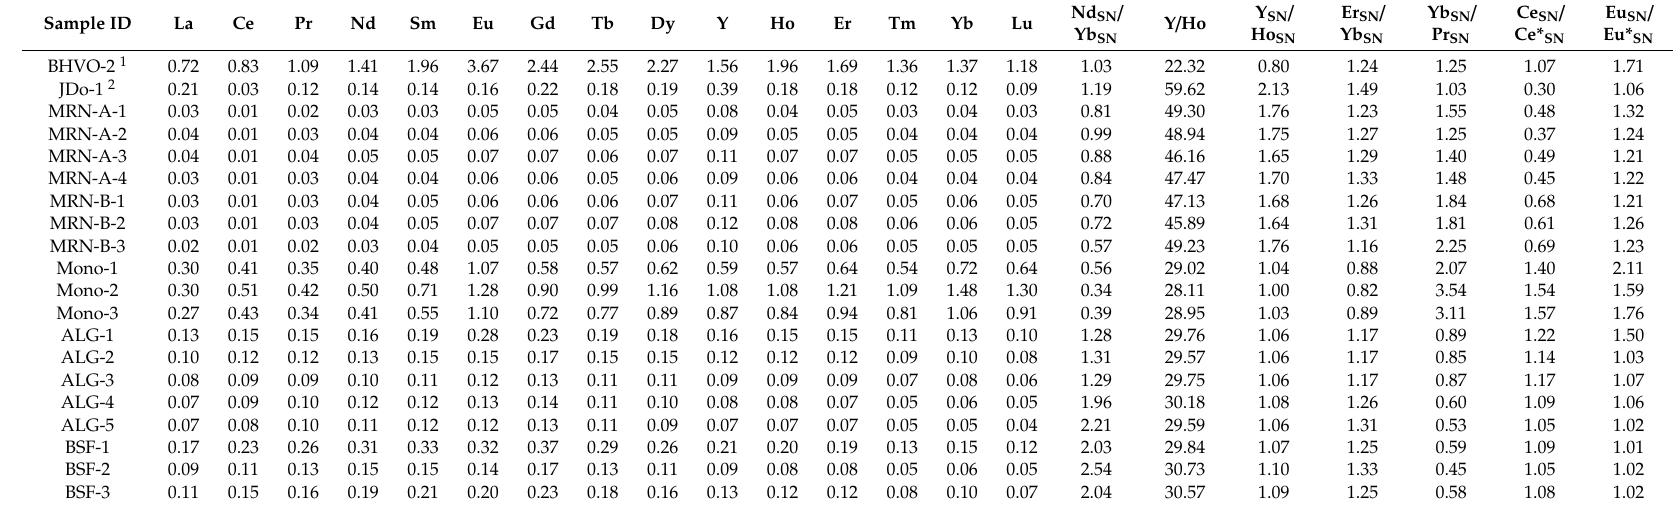
Table 4. Calculated REY ratios for samples and